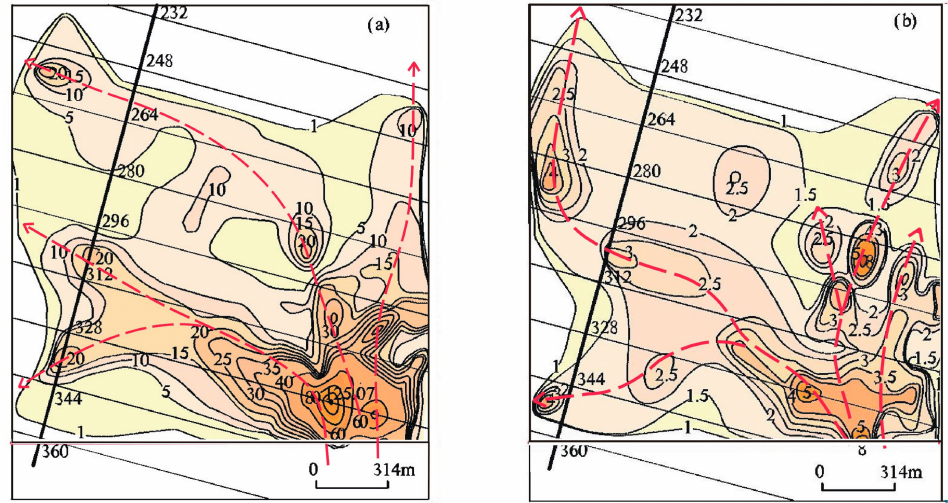
Figure 2. ( a ) Thickness isoline (unit: m) and ( b ) grade isoline (unit: ppm) for ore body I-2 in the Shaling deposit (modified after [15]). Red lines indicate the branches and extension direction of